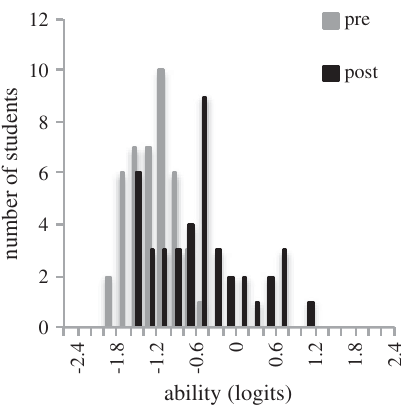
FIG. 34. The pre- and postability histogram for class 20.